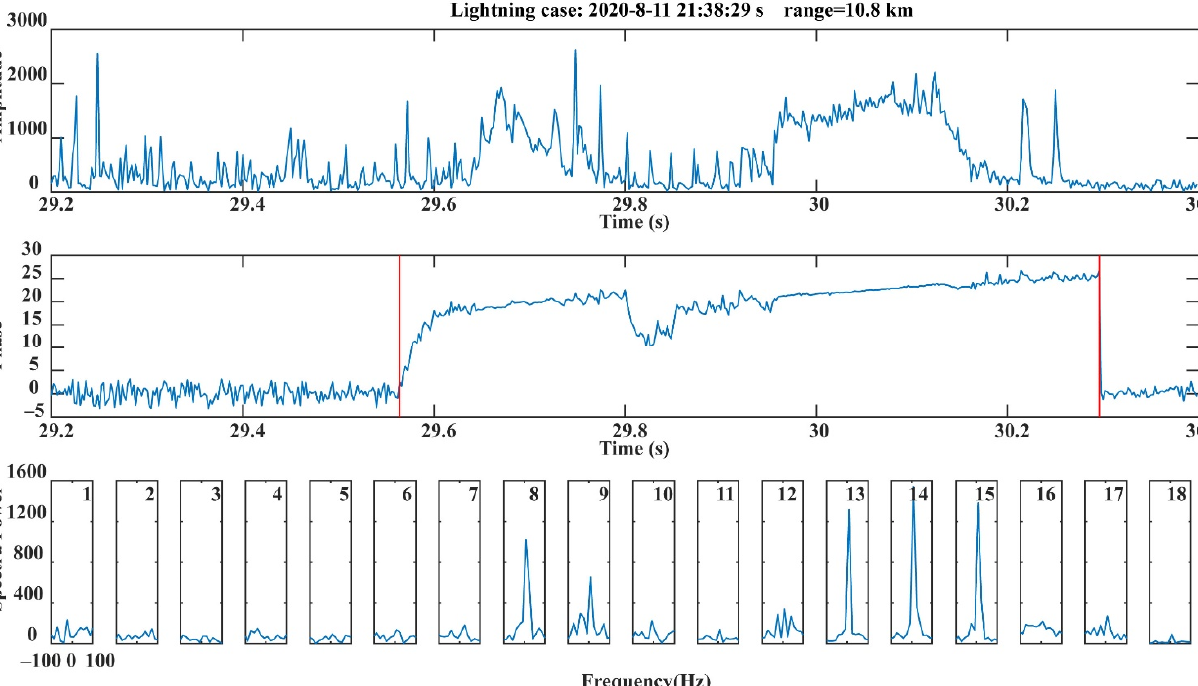
Figure 8. Amplitude, phase, and doppler spectra of I\Q raw data. The doppler spectra windows are numbered in the right corner of the subpanel. Each subpanel is calculated using 32 data points of the selected raw complex signal. The scale of the time axis is the same as in Figure 4, which starts from 29.2 to 30.4 s.